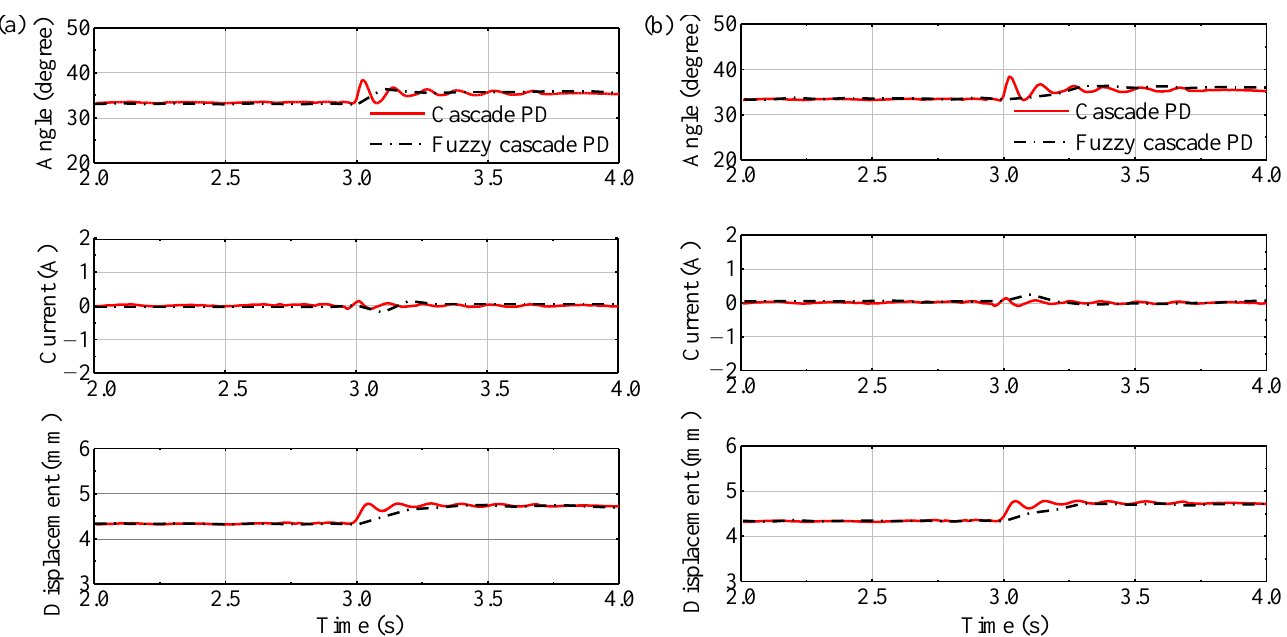
Figure 9. Experimental results of the displacement disturbance: ( a ) position loop fuzzy cascade control; ( b ) angle loop fuzzy cascade control.